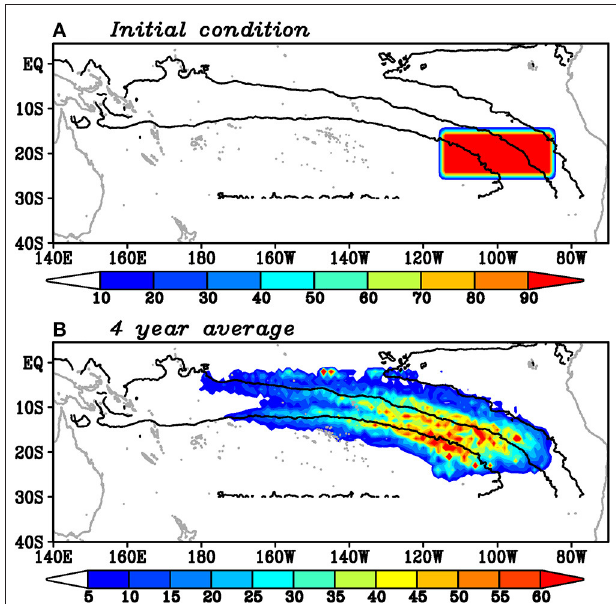
FIGURE 6 | (A) Initial condition and (B) 4-year average of passive tracer concentrations (color) on the 25–25.5 σ θ isopycnals along with the 6,000, 7,000, and 8,000kg m − 1 s − 2 isopleths of the mean Montgomery potential